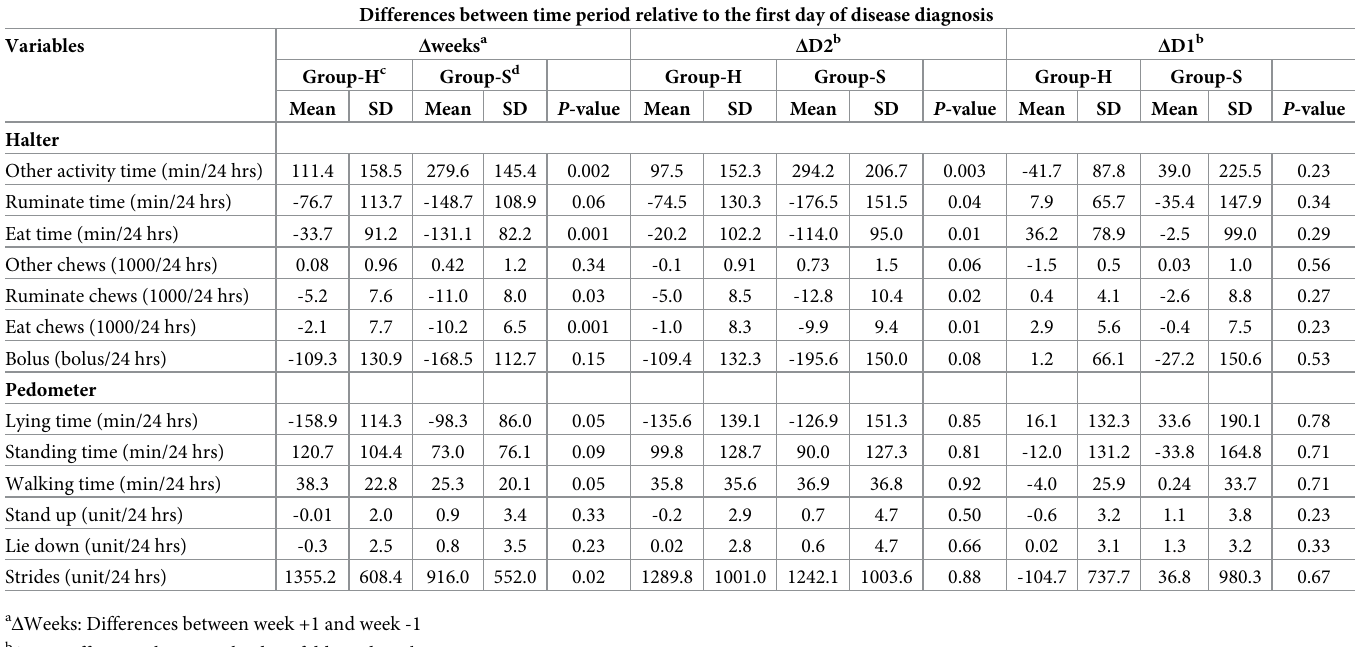
Table 5. Mean values of variables of RumiWatch 1 halters and pedometers of group-H and group-S cows at Δ D1, Δ D2, and Δ weeks. Differences between time period relative to the first day of disease